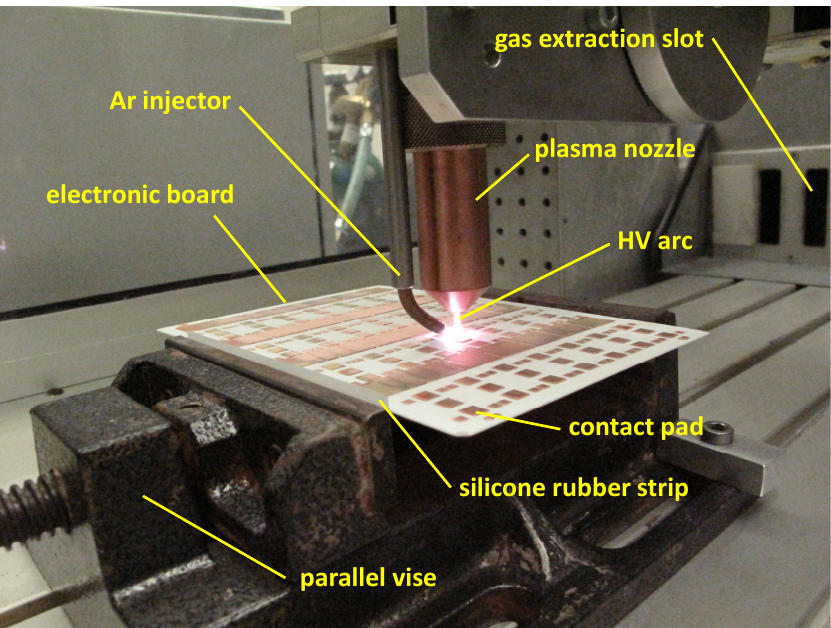
Figure 2. The copper contact pads distributed at the alumina plate are grounded by the Ar plasma bridge during processing with the PAA-PJ. The plasma generator is fed with FG